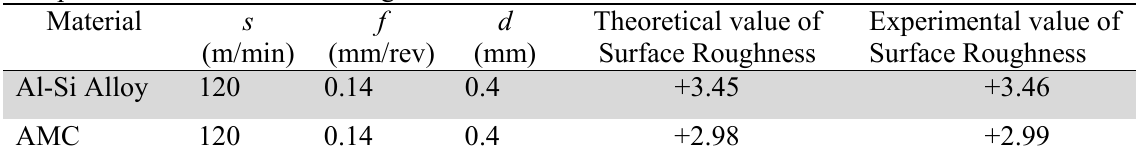
Comparative value of surface roughness for two materials at base level Material